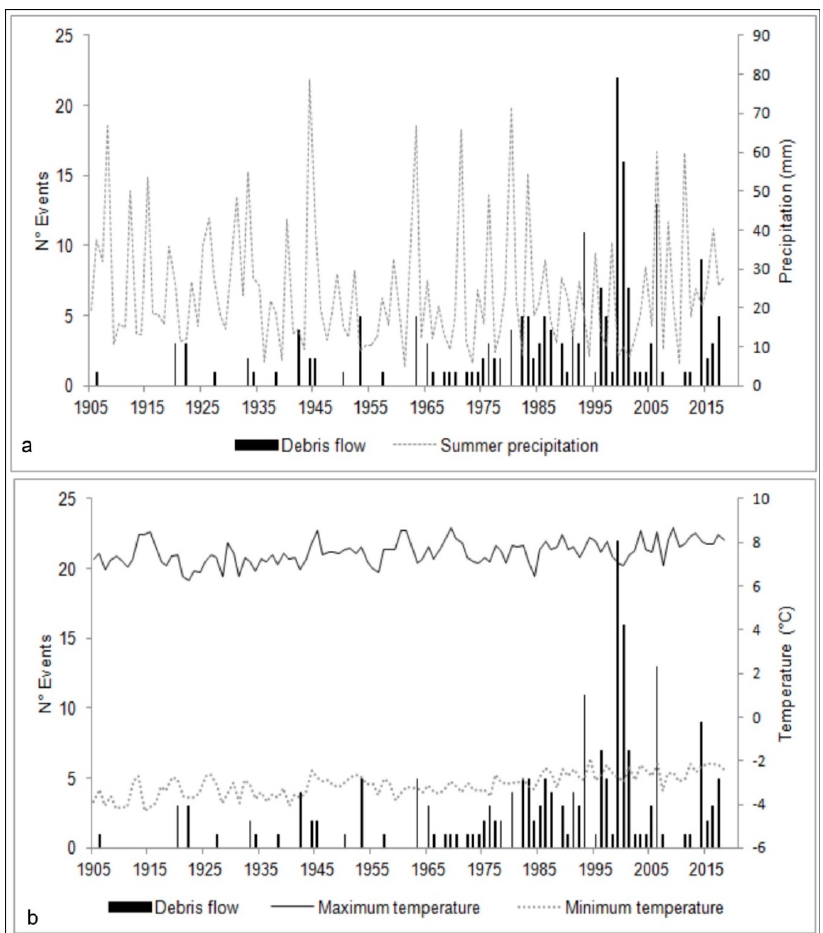
Figure 7. ( a ). Series of summer precipitation and documented DFs in the Mendoza river valley, and ( b ). Series of minimum and maximum annual temperatures and documented DFs in the Mendoza river valley. Records were obtained from database Climate Research Unit (CRU) TS4.03 [102].